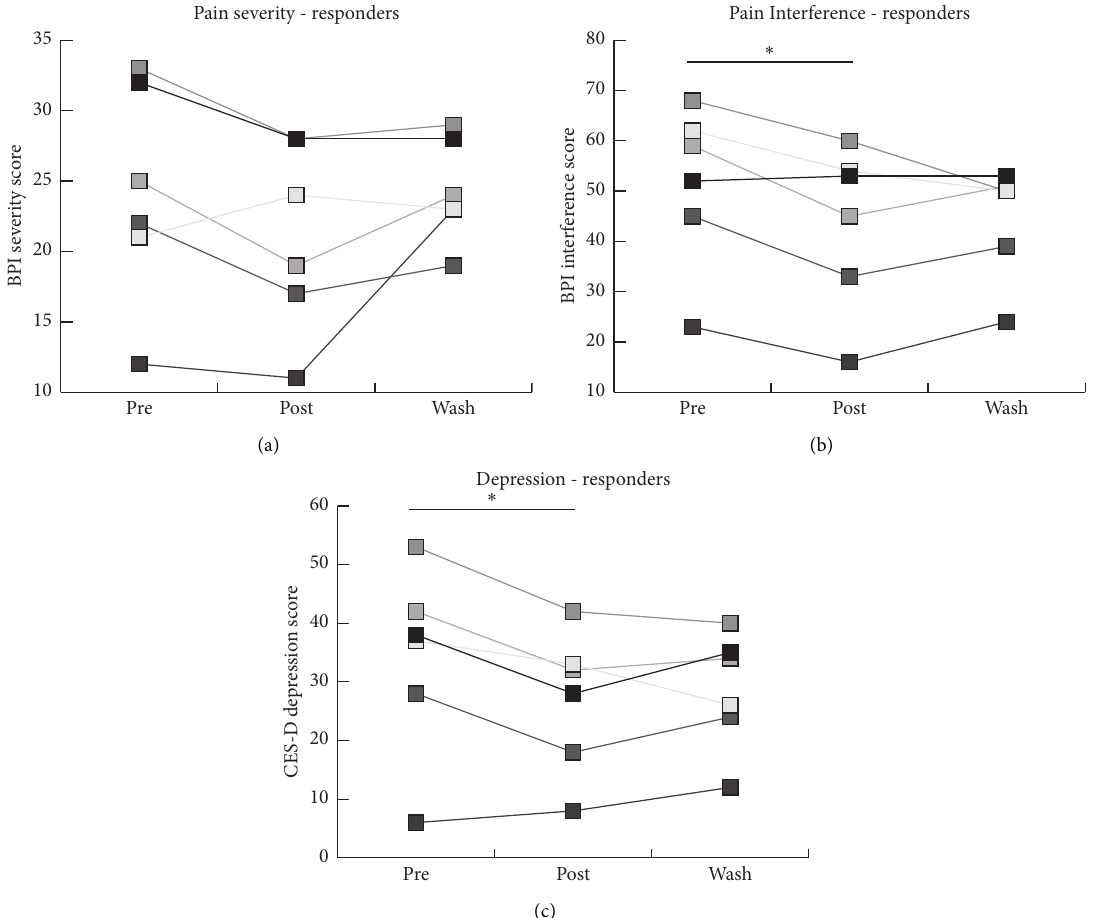
Figure 3: Analysis of effects of the intervention on pain interference and mood for responders. (a) Line graph depicting BPI-severity scores in patient responders at all time points in response to the intervention. (b) BPI-interference scores in patient responders in response to the intervention. (c) CES-D scores in patient responders in response to the intervention. ∗ p < 0 .